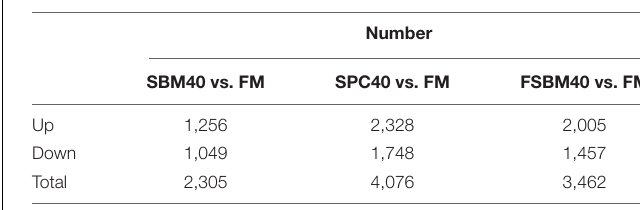
TABLE 5 | Comparison of the significantly differential expressed genes of the three soy protein substitutions for fish meal in the distal intestine of the pearl gentian grouper ( n = 4).